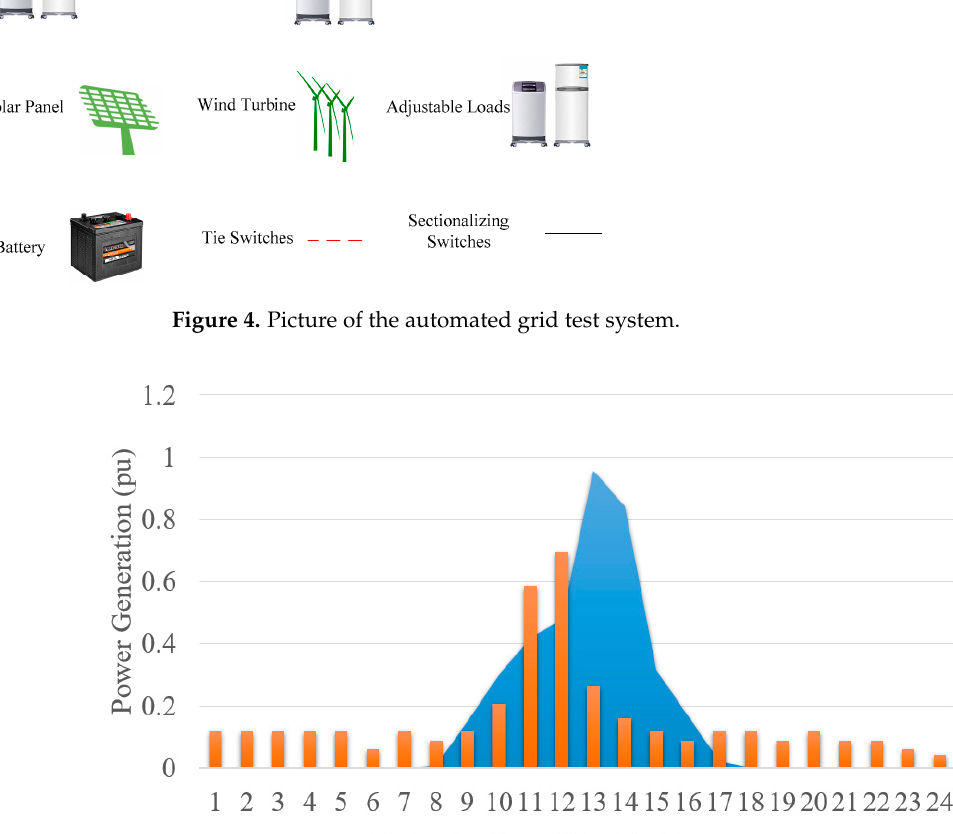
4 Table 5. Characteristics of adjustable loads (s: shiftable, c: curtailable). Load